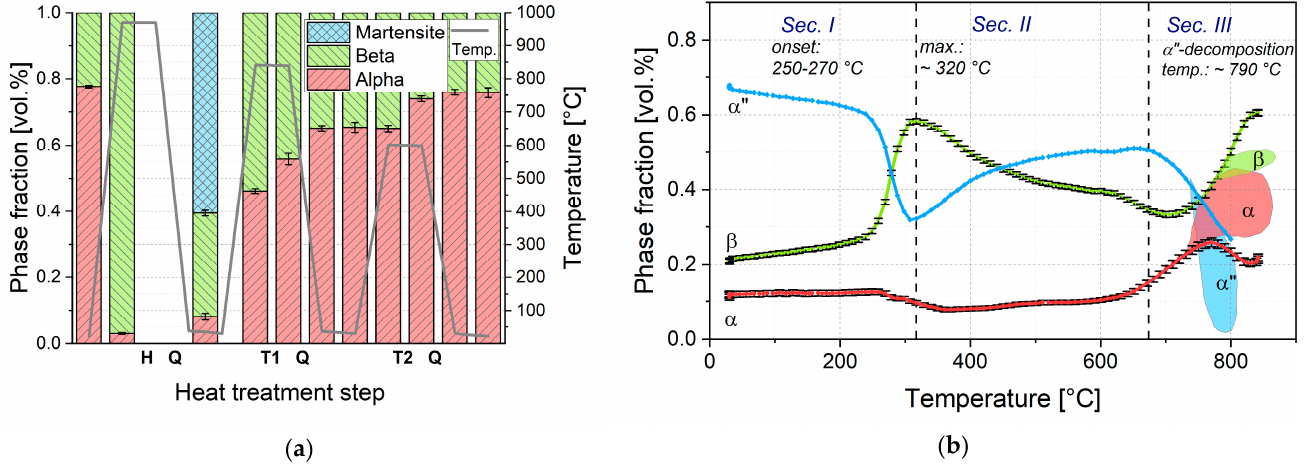
Figure 8. ( a ) Overview graph of the phase fractions and temperature profiles vs. heat treatment step (M_970_840_600); ( b ) Evolution of α -, β - and α″ -martensite phase fractions during continuous heat- ing to high-temperature tempering at 840 °C with corrected/expected (for explanation of the correc- tion of phase fraction, see discussion below) phase fractions in the high-temperature range (green, red and blue areas at 750–840 °C). (green, red and blue areas at 750–840 ◦